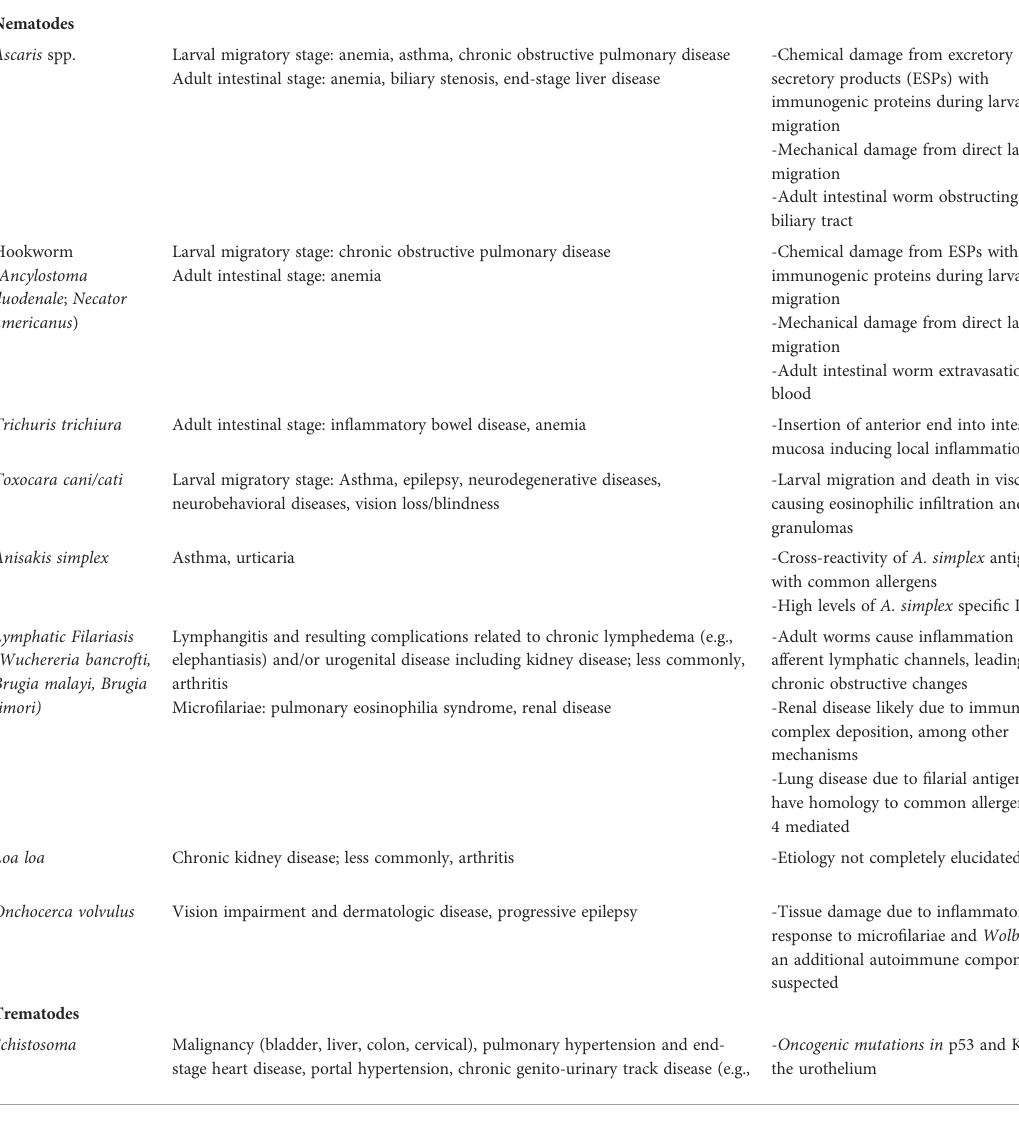
TABLE 1 Proposed mechanisms of helminth induced non-communicable diseases.